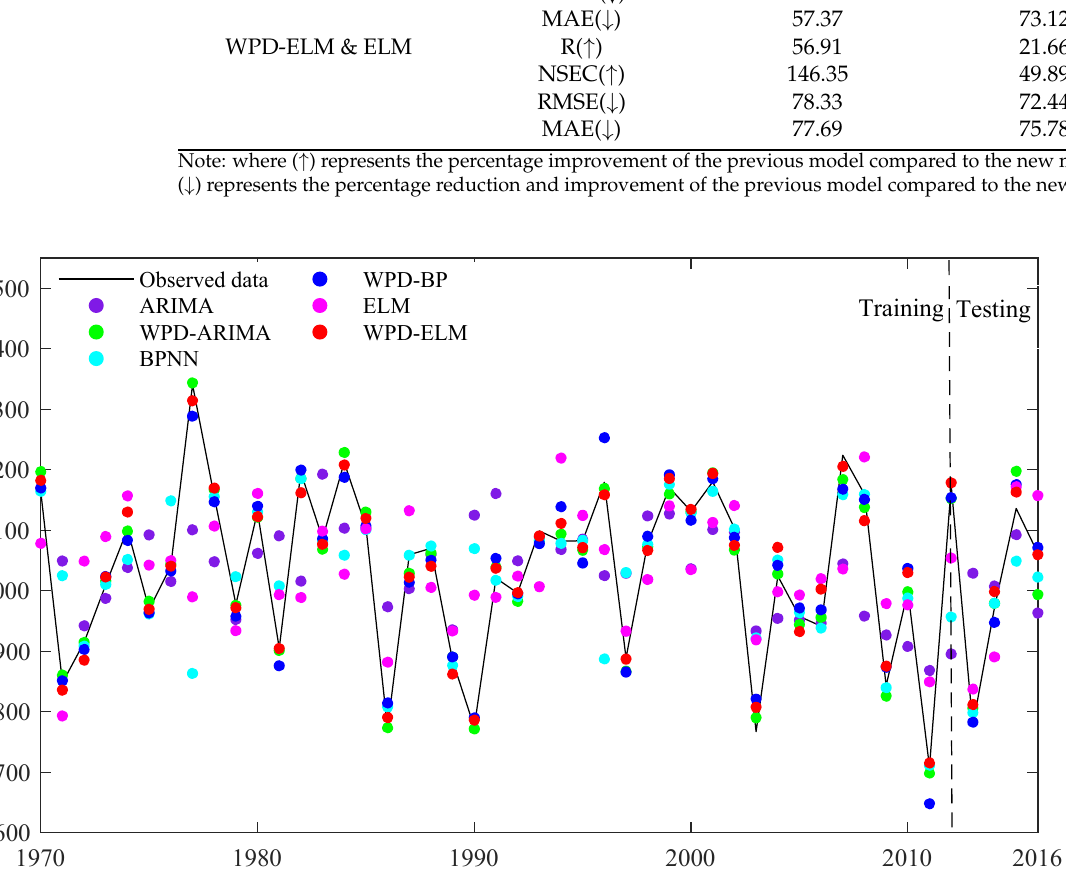
Table 5. Comparison of model prediction performances.